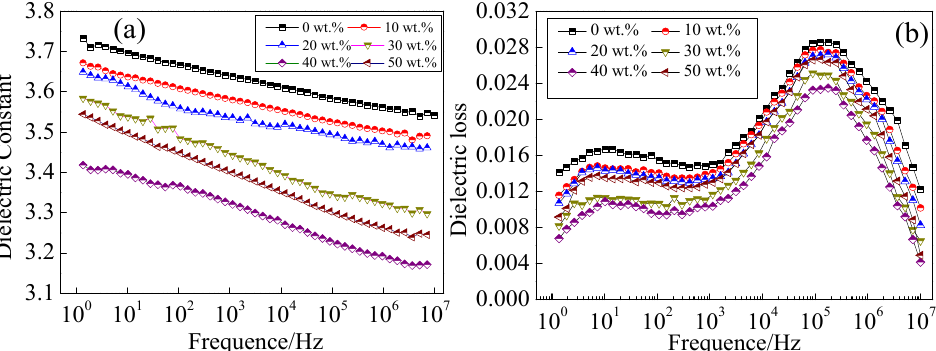
Figure 8. Dielectric property of modified BMI with different content of HBPI. ( a ) dielectric constant, ( b ) dielectric loss.